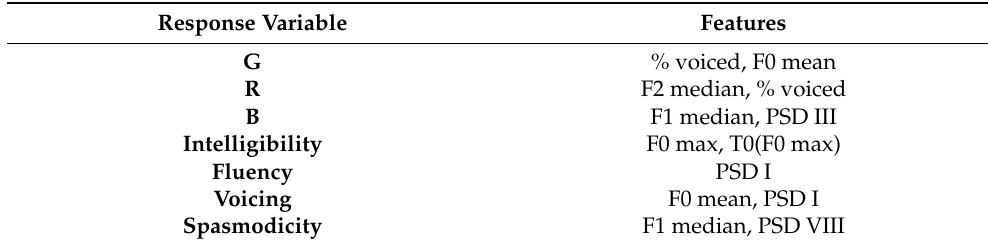
Table 5. Most relevant features obtained by averaging and normalizing LIME predictors’ weights for perceptual indices in the first AI